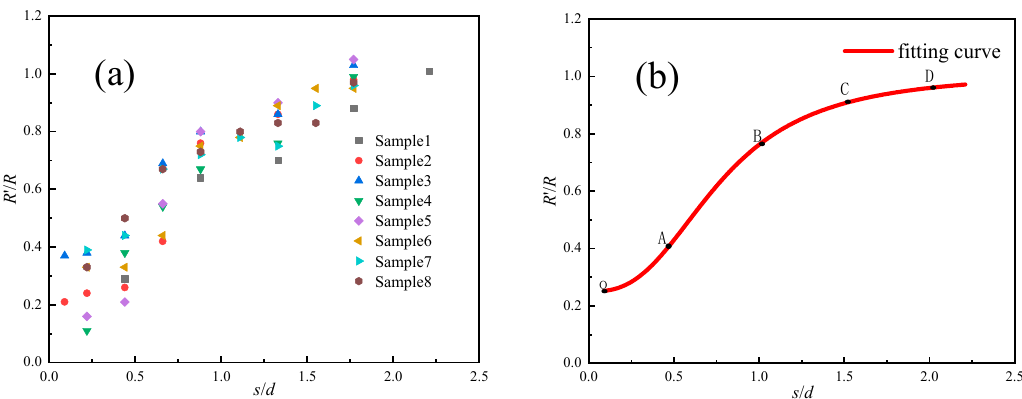
Figure 7. Intensity ratio-distance ratio nonlinear fitting relationship: ( a ) scatter plot of strength ratio (R ′ /R)-distance ratio ( s / d ) test data; ( b ) Nonlinear fitting curve of strength ratio (R ′ /R) -distance ratio ( s / d ). The distance ratio ( s / d ) is the proportion of the distance from the penetration test